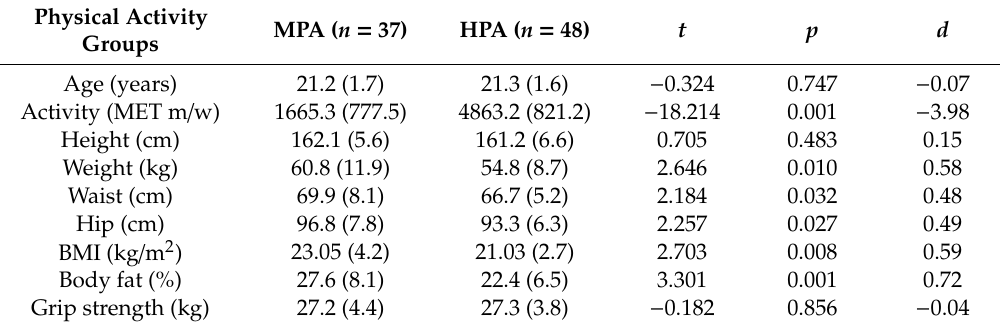
Table 2. Descriptive statistics, t-test results, and e ff ect size values for female